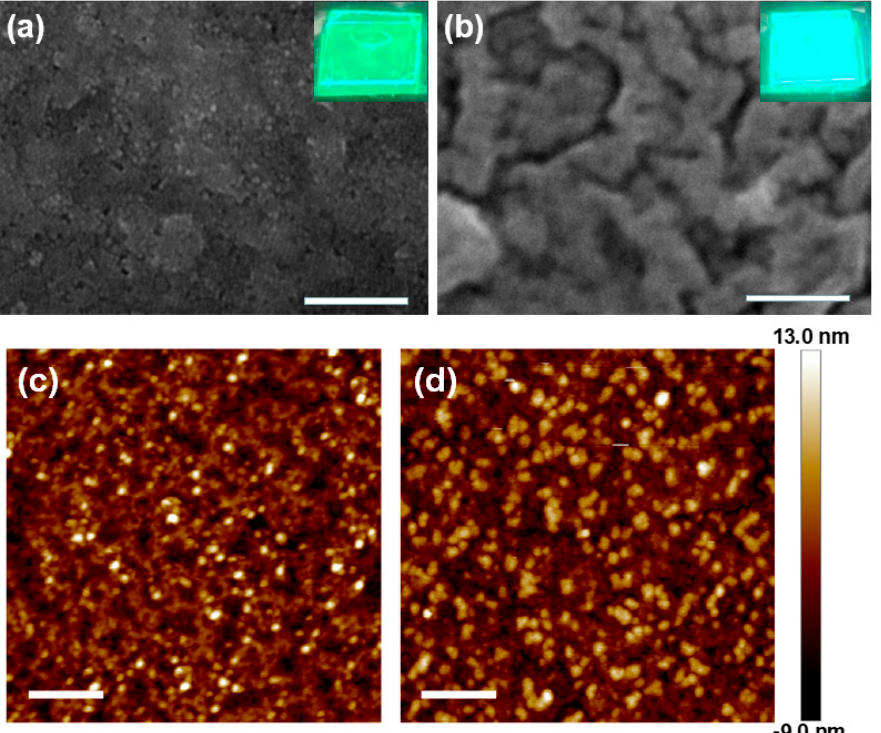
Figure 6. ( a , b ) SEM and ( c , d ) AFM images of the CsPbBr 3 and CsPbBr 3 :Zn NCdeposited on glass, respectively. Insets of ( a , b ) are the corresponding top-view photographs under UV light illumination. The scale bar in SEM and AFM images represents 250 nm and 1 μ m, respectively.